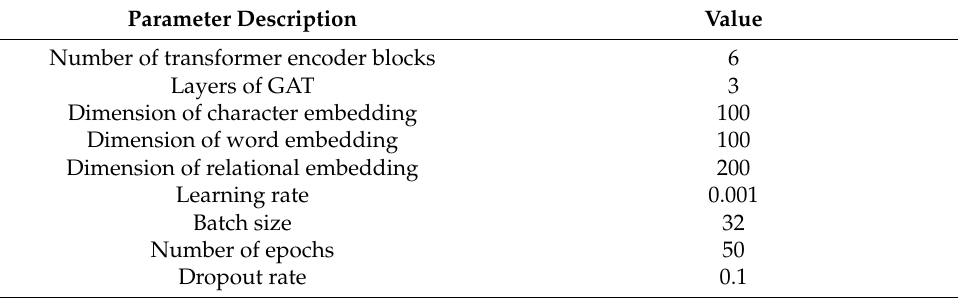
Table 3. Experimental